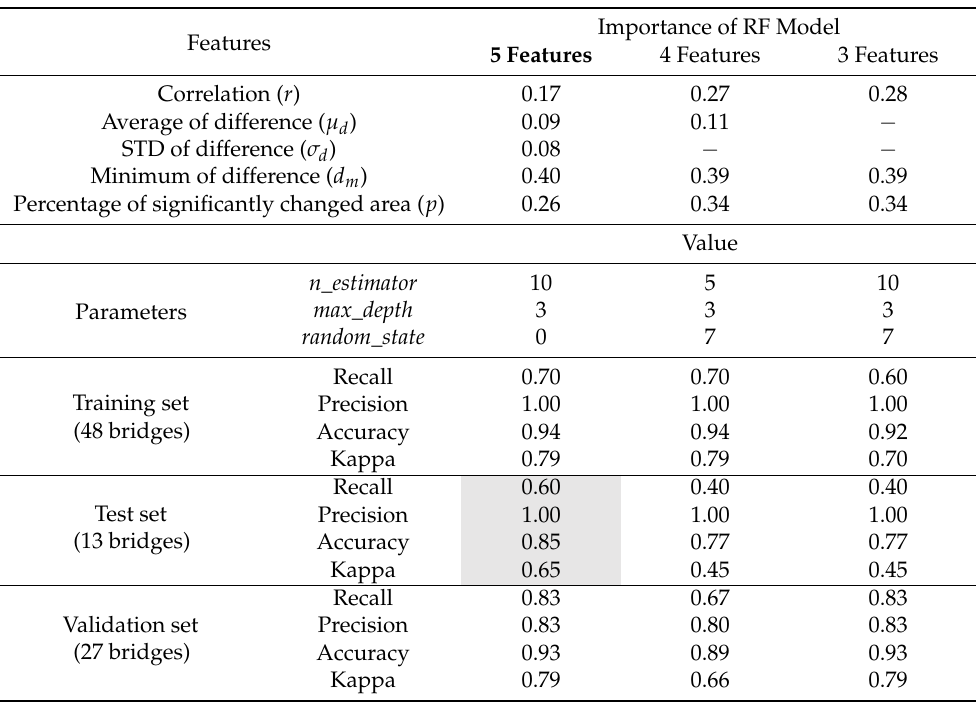
Table 8. Comparison of RF models using data set 2 with different numbers of features; the best model is emphasized in bold font. The highest accuracy for the test data is emphasized by the gray background.